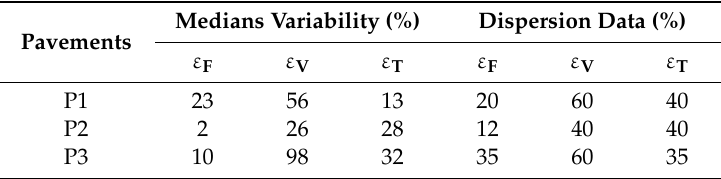
Table 5. E ffi ciency